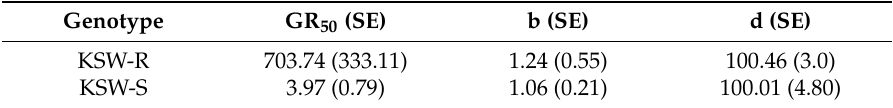
Table 2. Regression parameters describing the response of wild buckwheat populations KSW-R (resistant) and KSW-S (susceptible) to chlorsulfuron; herbicide rate required for 50% growth reduction (GR 50 ), slope of the curve (b), upper limit (d) and, standard error (SE).